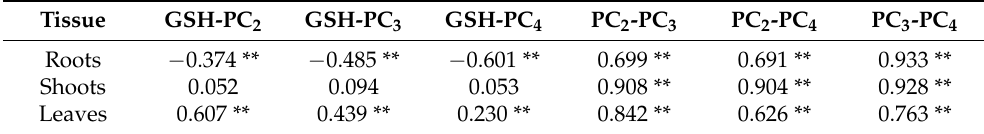
Table 1. The relationships among the contents of the thiols in the different tissues. Tissue GSH-PC 2 GSH-PC 3 GSH-PC 4 PC 2 -PC 3 PC 2 -PC 4 PC 3 -PC 4 Roots − 0.374 ** − 0.485 ** − 0.601 ** 0.699 ** 0.691 ** 0.933 ** Shoots 0.052 0.094 0.053 0.908 ** 0.904 ** 0.928 ** Leaves 0.607 ** 0.439 ** 0.230 ** 0.842 ** 0.626 ** 0.763